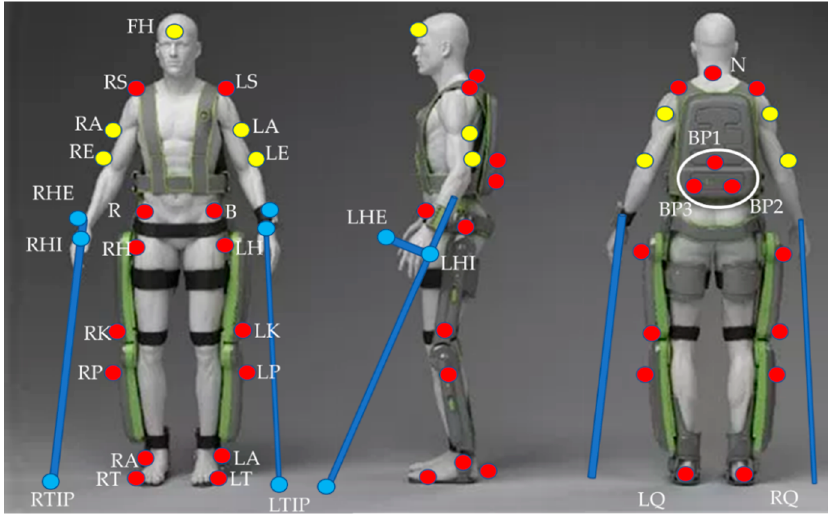
Figure 6. Position of the retroreflective markers. Red dots indicate markers from the original Davis protocol, yellow dots indicate added markers on the subject, and blue dots indicate markers placed on the